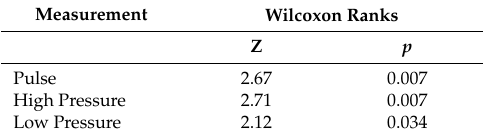
Table 4. Physiological measurements and Wilcoxon ranks before and